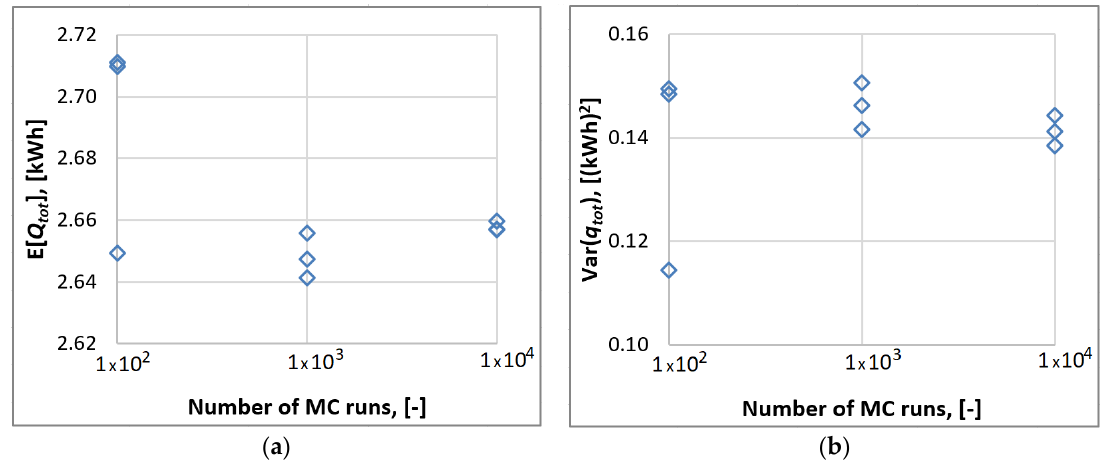
Figure 9. Comparison of ( a ) expected values and ( b ) variance of the total heat flux in January obtained using the Monte Carlo method for different number of the Monte Carlo runs for Case 3.